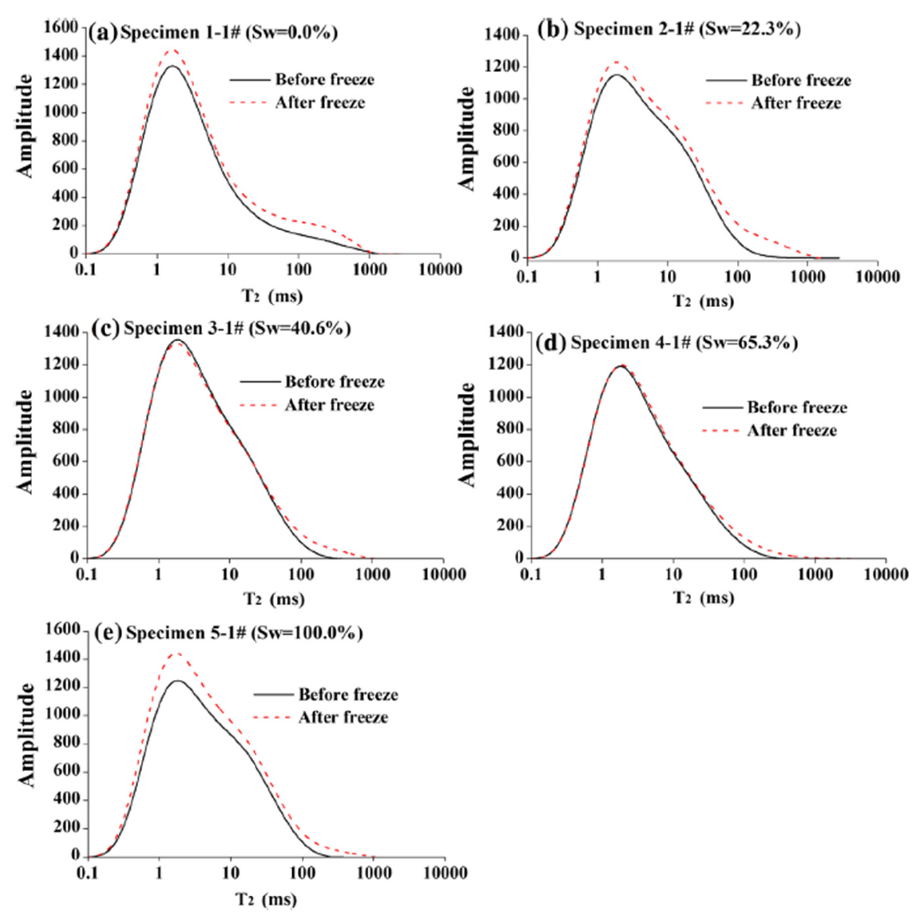
Figure 1. T 2 distributions for coal samples before and after freezing with LN 2.